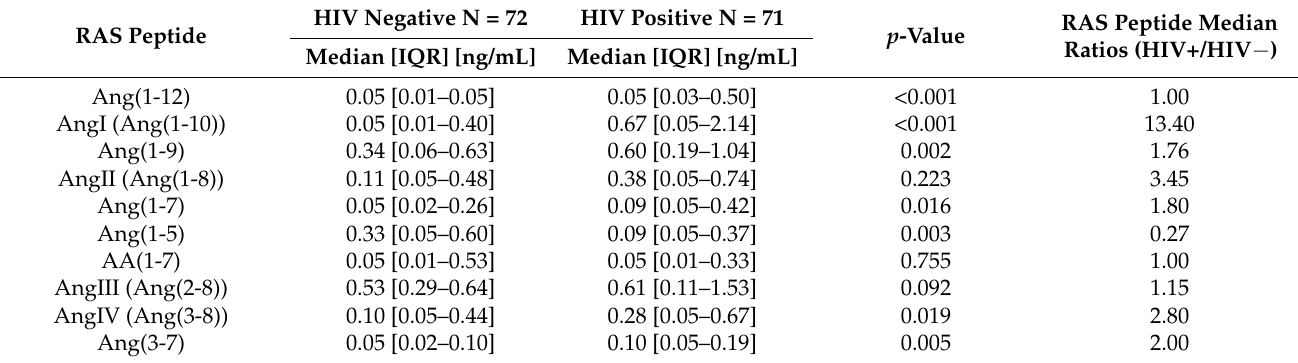
Table 2. Circulating plasma RAS peptide levels of all patients at study entry.